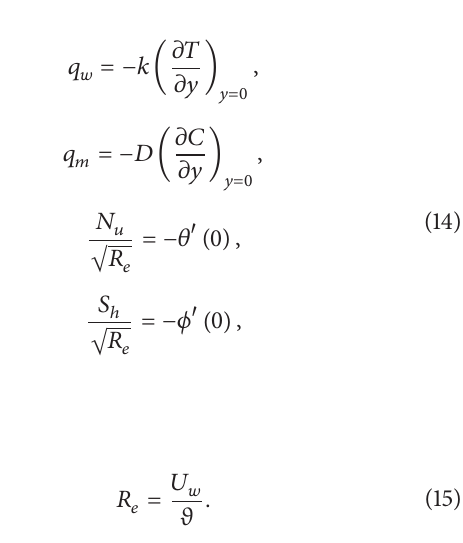
Figure 2: Velocity distribution for different values of 𝑀 .